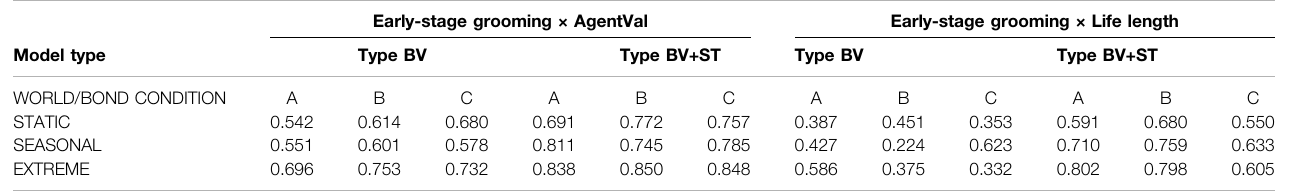
TABLE 7 | Results of r-values of Pearson ’ s Correlation Coef fi cient tests between the number of early-stage (i.e., before 2,000 time steps) intra-bond Grooming interactions and mean AgentVal ∖ Chi value across both model types, bond conditions and world conditions. Early-stage grooming × AgentVal Early-stage grooming × Life